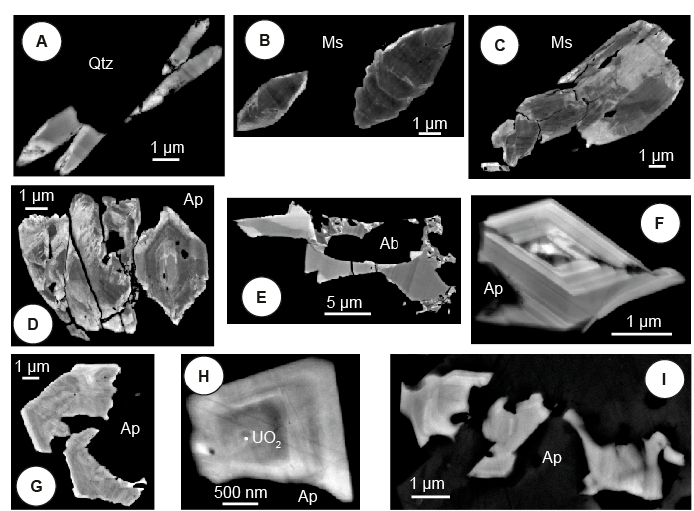
Figure 17. Nb–Ta–W oxides in the G3 micro-leucogranite (sample PAN-16-9) (SEM-BSE images). ( A – E ) Columbite-tantalite/wolframo-ixiolite. ( A ) Small acicular prisms hosted in quartz (Qtz). Note the OZ and the bright W-rich ixiolite overgrowths. ( B ) Small blocky crystals hosted in muscovite (Ms). Note the conspicuous OZ. ( C ) Blocky prisms in muscovite. Note the importance of the W-rich ixiolite overgrowths. ( D ) Oscillatory zoned crystals hosted in apatite. Note the bright W-rich ixiolite overgrowth and ingress into the OZ crystals. ( E ) The crystal is interstitial in a magmatic albite aggregate. ( F – I ) Nb-rich rutile. Note the bright Ta-rich overgrowth in ( G ) and the nano-inclusion of uraninite in the core of the oscillatory zoned crystal in ( H ).